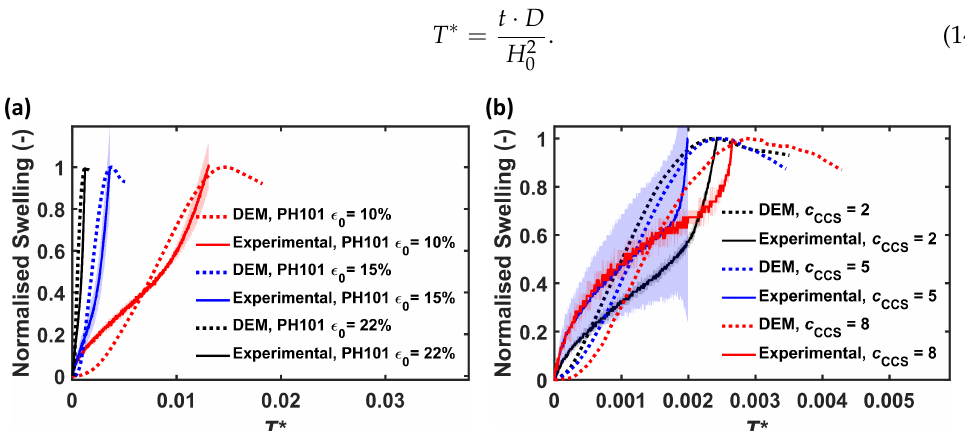
Figure 6. Analysis of the DEM simulation of PH101 tablets and comparison to experimental results, normalised swelling by height, as a function of normalised time, T ∗ . ( a ) PH101 tablets; ( b ) PH101/CCS tablets. The solid line and shaded area correspond to the average and standard deviation, respectively, of three samples (two for PH101/CCS, c CCS =